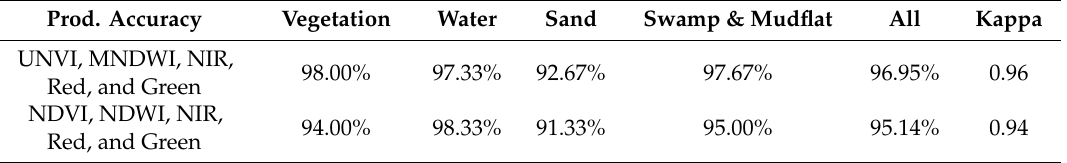
Table 3. Classification accuracy of di ff erent band combinations in